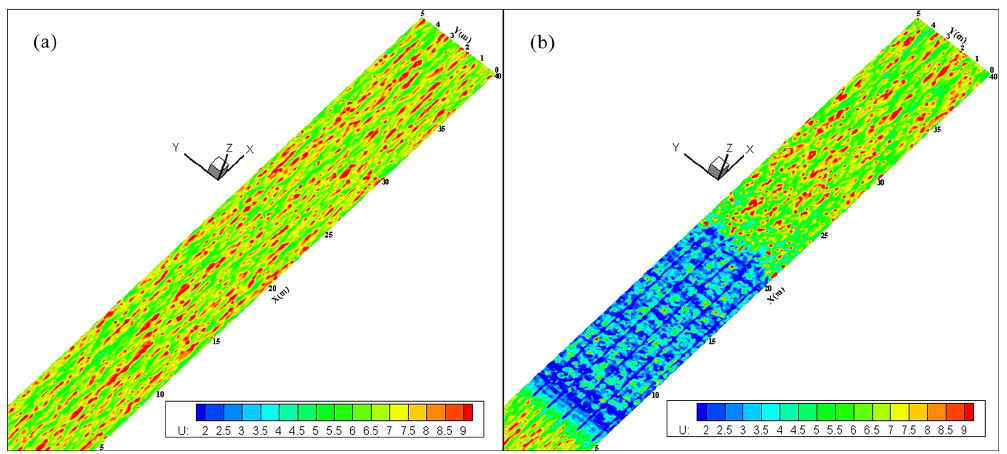
Figure 7. The top view of x – y -plane streamwise velocity without (a) and with (b) the SCBs ( z = 0 . 005m; u τ = 0 . 6ms − 1 ; N = 5–20m).